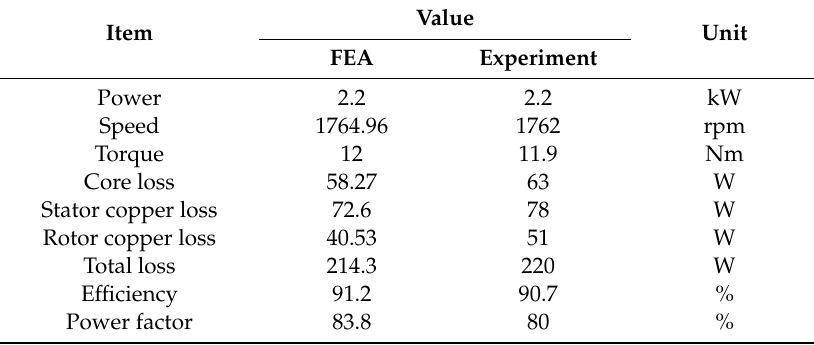
Table 2. FEA and experiment result of reference model.